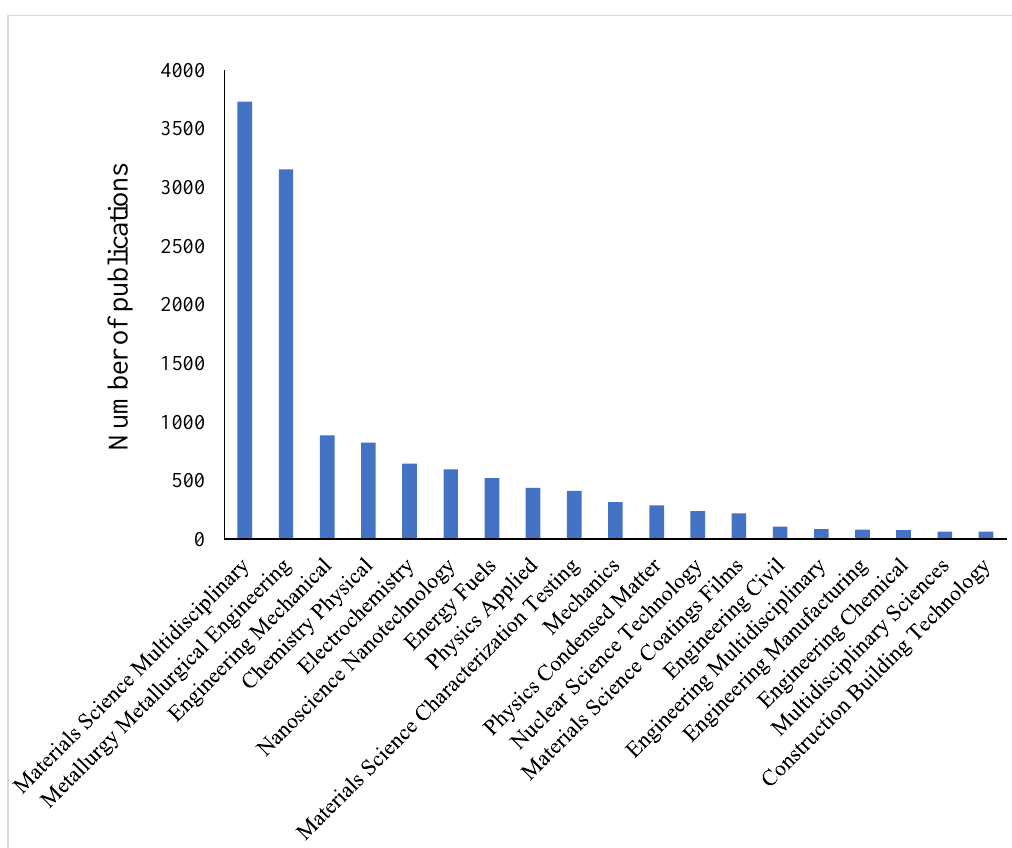
Figure 10. The subject categories with more than 60 publications on hydrogen embrittlement.